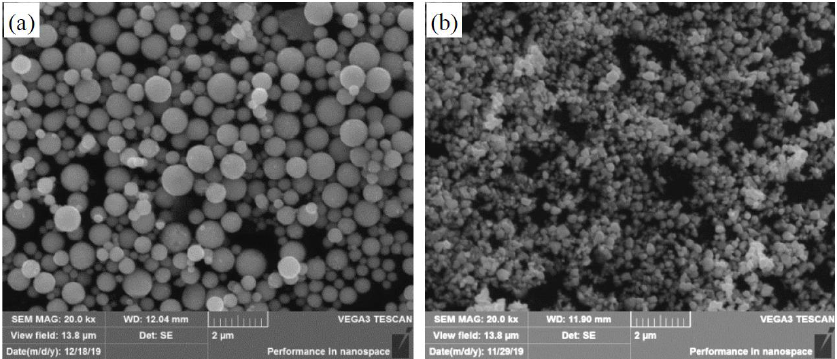
Figure 2. Micromorphologies of pure Cu powder and pure W powder: ( a ) Cu powder; ( b ) W powder. Microscopic images of the Cu-W composite powders with different W contents are shown in Figure 3. In the figure, the gray particles are Cu and the white particles are W.